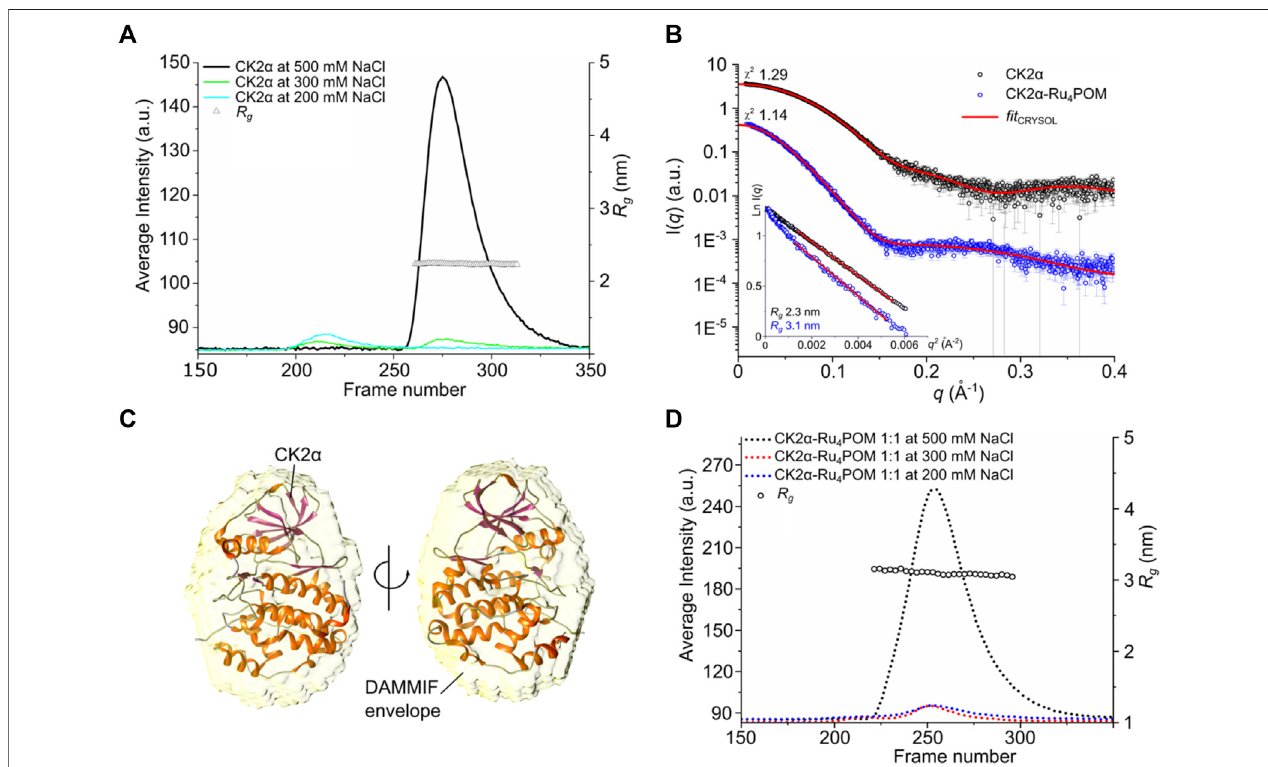
FIGURE7| SAXSstudiesonCK2 α -Ru 4 POMcomplex. (A) SEC-SAXSchromatogramsof R g andI(0)tracesasfunctionsofframesofseparatedCK2 α ,inbufferwith 0.5, 0.3, and 0.2 M NaCl (black, green, and cyan lines, respectively). Triangles represent the calculated radius of gyration, R g in nm, in the selected frames collected in buffercontaining0.5 MNaCl. (B) I ( q )versus q experimentalSAXSpro fi lesforCK2 α andCK2 α -Ru 4 POM(blackandbluecircle,respectively)withCRYSOL fi t(redlines). χ 2 values for the CRYSOL fi tting are indicated. The curves are shifted by an arbitrary offset for better comparison. In the inset , the Guinier fi ts for the two samples and thecalculatedradiusofgyrationareshown. (C) CK2 α DAMMIFmodel(yellowenvelopeshownintransparency)overlaidwiththeCK2 α crystalstructure(PDBentry3q04). (D) SEC-SAXS chromatograms of R g and I(0) traces as functions of frames of separated CK2 α -Ru 4 POM complex at 1:1 M ratio and increasing NaCl concentration.